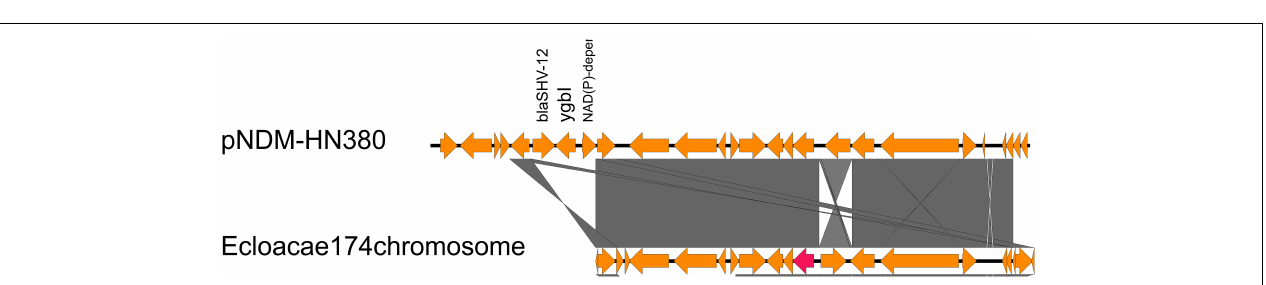
FIGURE 3 | Comparison of AR_N1_I structure of pNDM-HN380 with the Enterobacter cloacae 174 chromosome gene fragment in